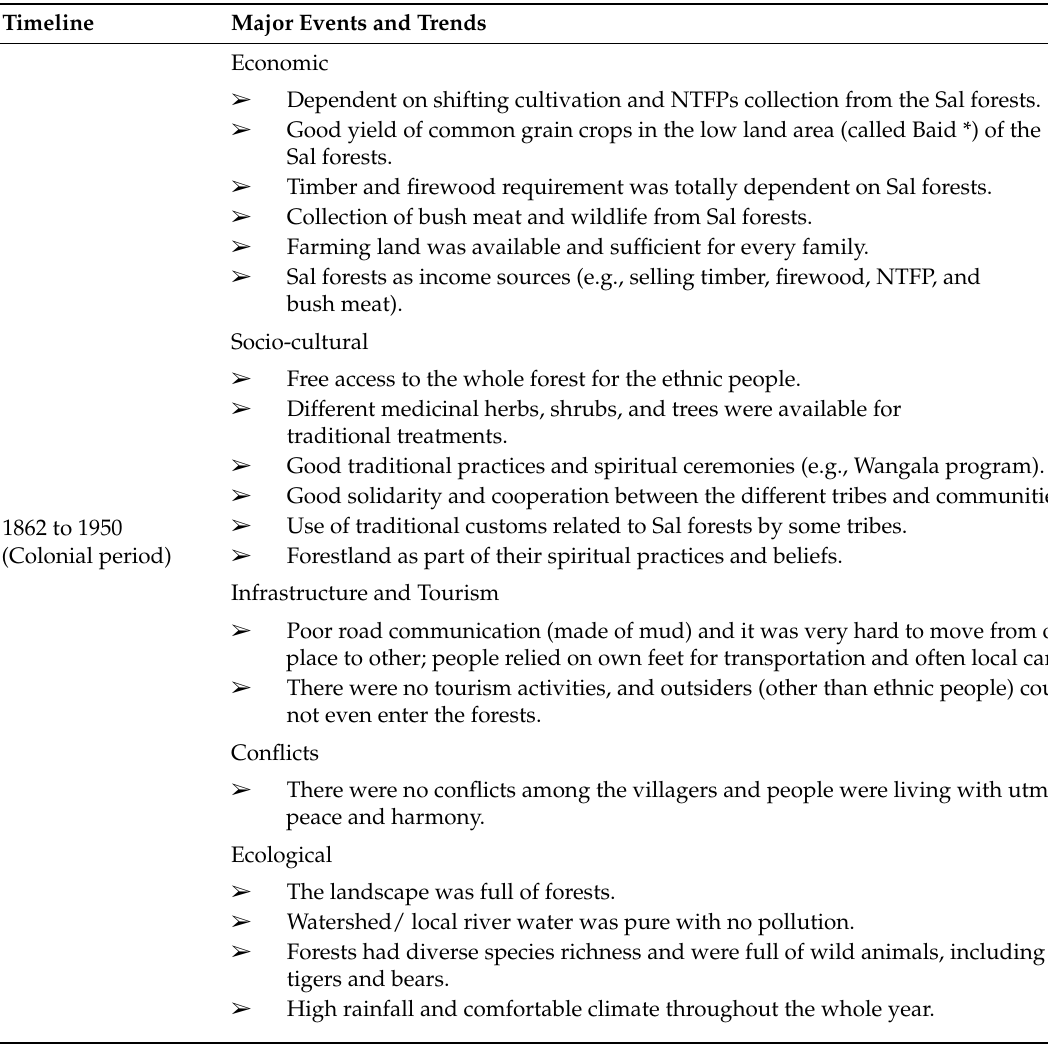
Table 5. Timeline of the living condition of the ethnic minorities in the